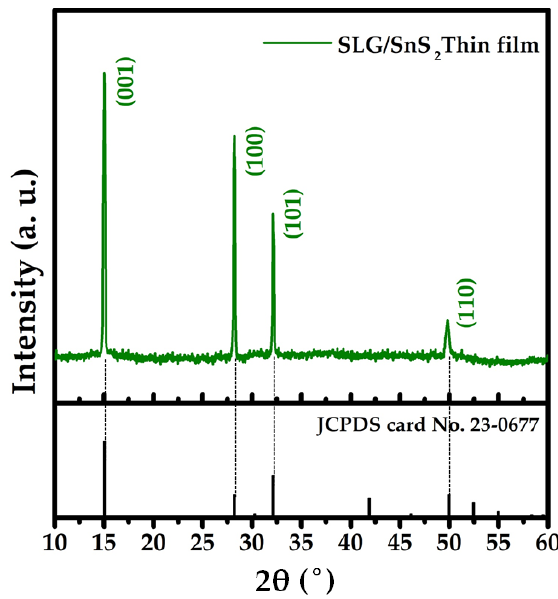
Figure 7. XRD profile of SnS 2 thin